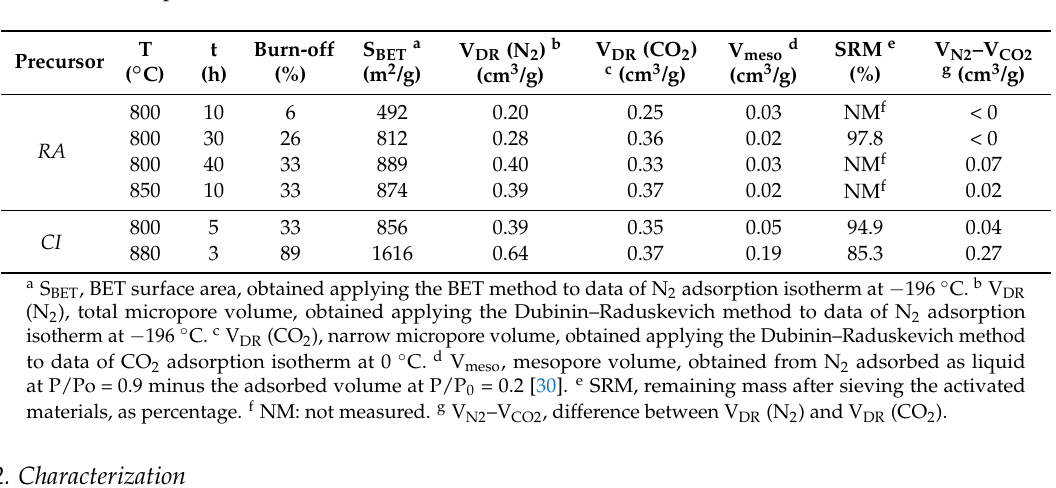
Table 3. Activation conditions, activation percentages, SRM values and textural properties of some activated